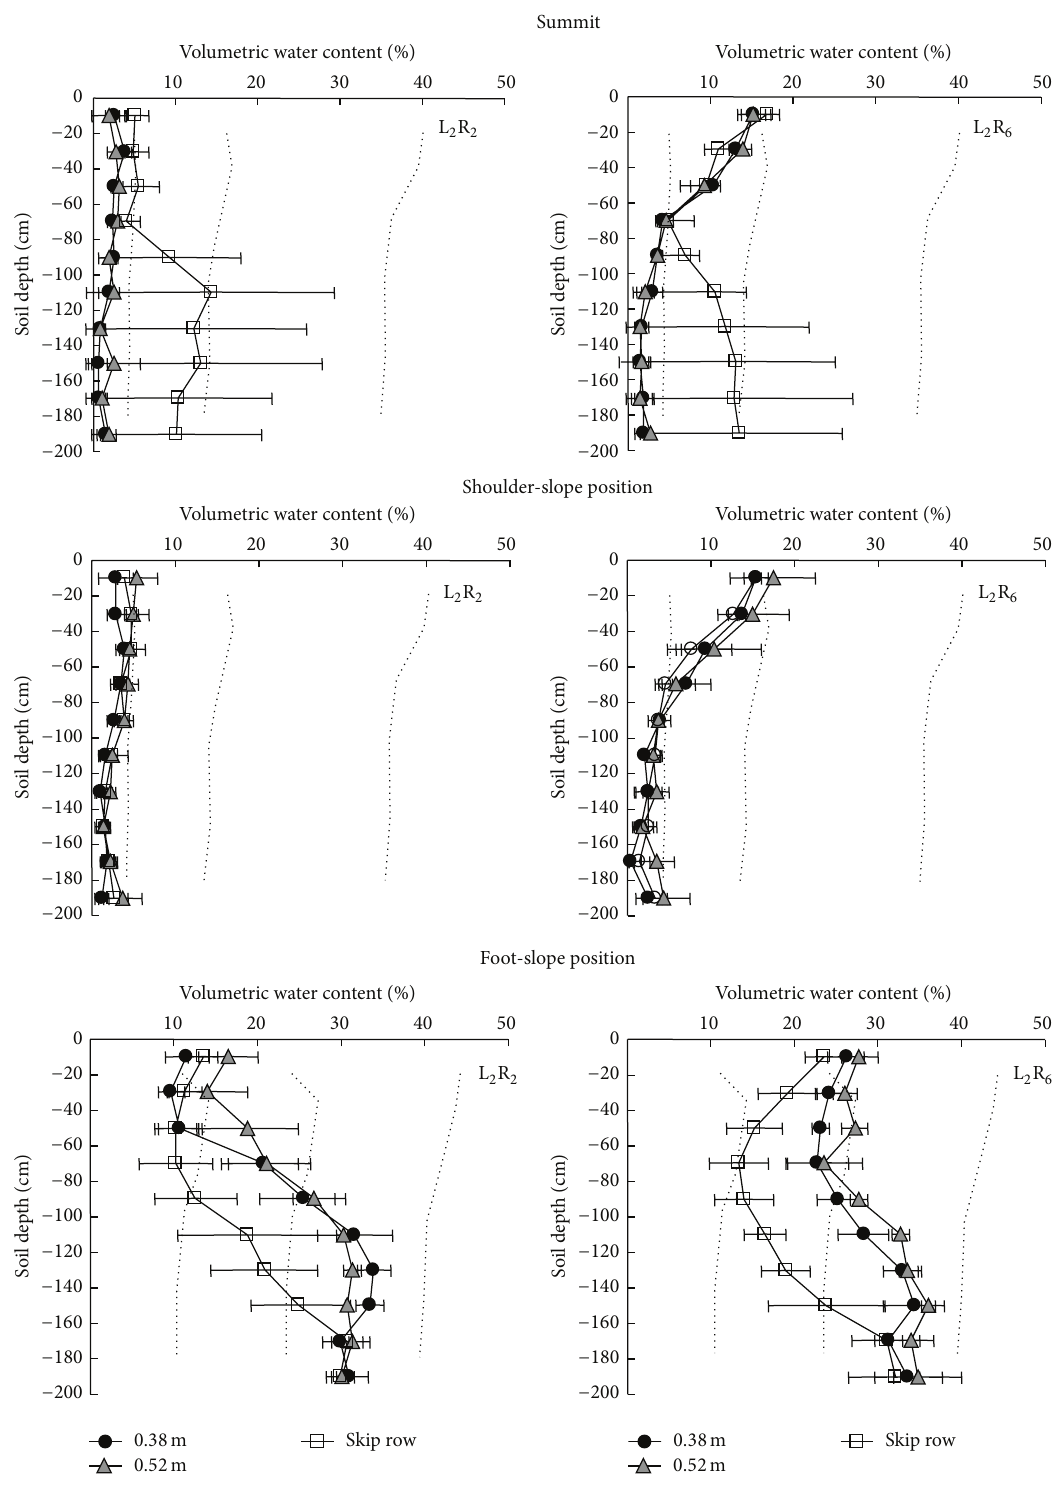
Figure 2: Volumetric water contents of soil profiles (0–200cm depth) close to silking (R 2 ) and at physiological maturity (R 6 ) of maize crops cultivated at three landscape positions (summit, shoulder-slope position, and foot-slope position) and three row spacings (0.38 m, 0.52 m, and 0.38 m in a 2 × 1 skip-row pattern) during 2007/08 (location 2; L 2 ). Values are the mean ± standard error of three replicates. Dotted lines indicate volumetric water contents at lower limit, upper limit, and saturation determined in